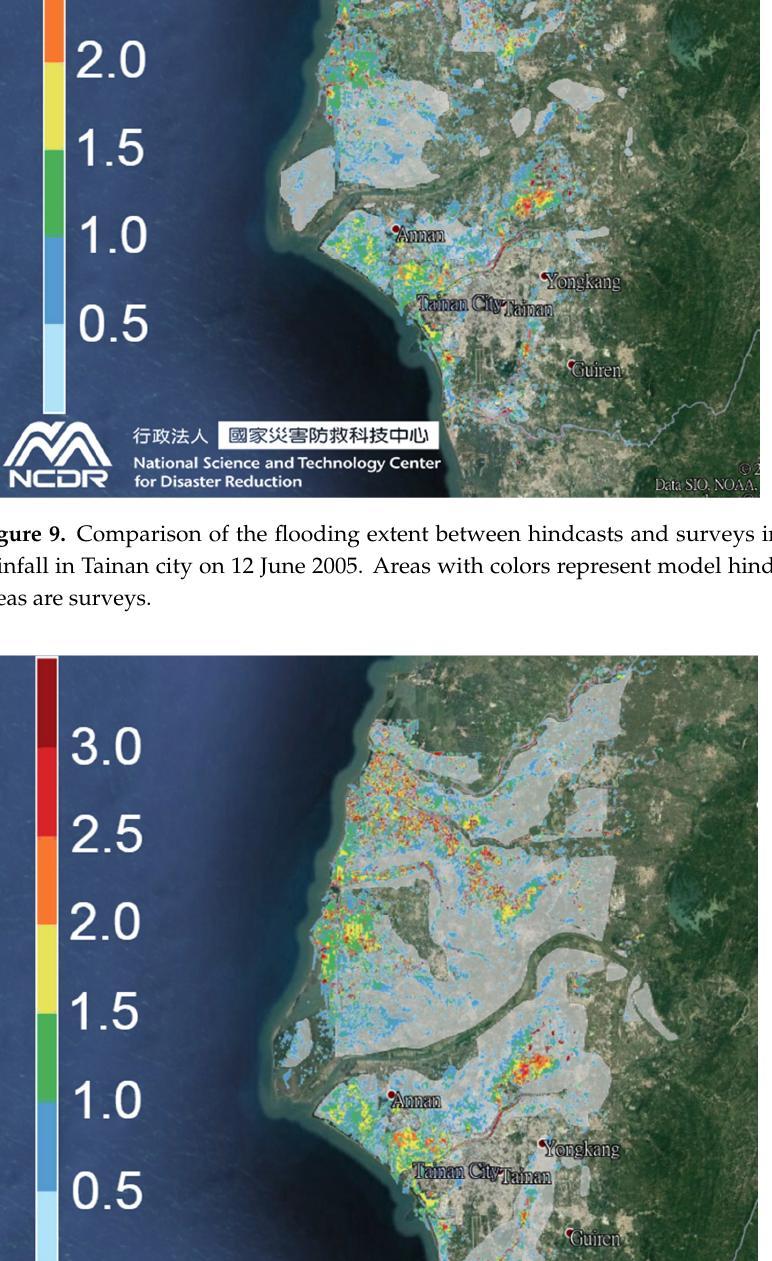
Figure 10. Comparison of the flooding extent between hindcasts and surveys induced by intense rainfall in Tainan during Typhoon Morakot in 2009. Areas with colors represent model hindcasts, while white areas are surveys.